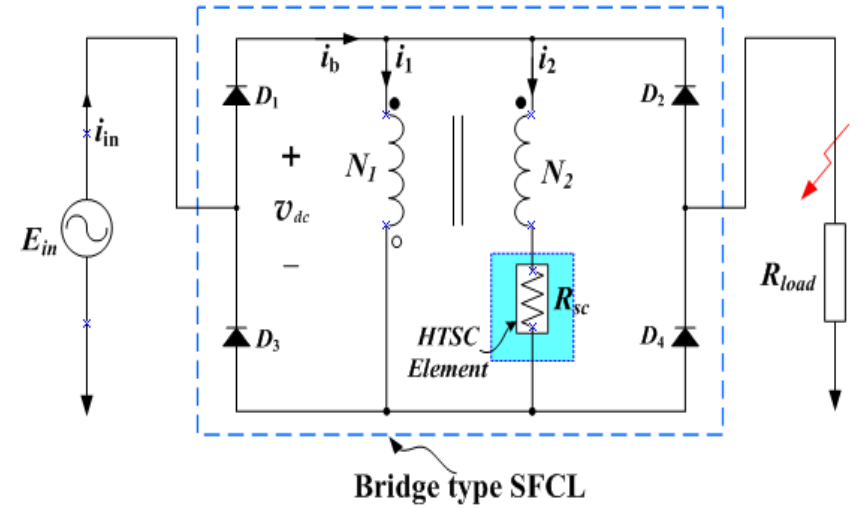
Figure 1. Schematic configuration of bridge type superconducting fault current limiter (SFCL) with a single high-temperature superconducting (HTSC) element using flux-coupling.